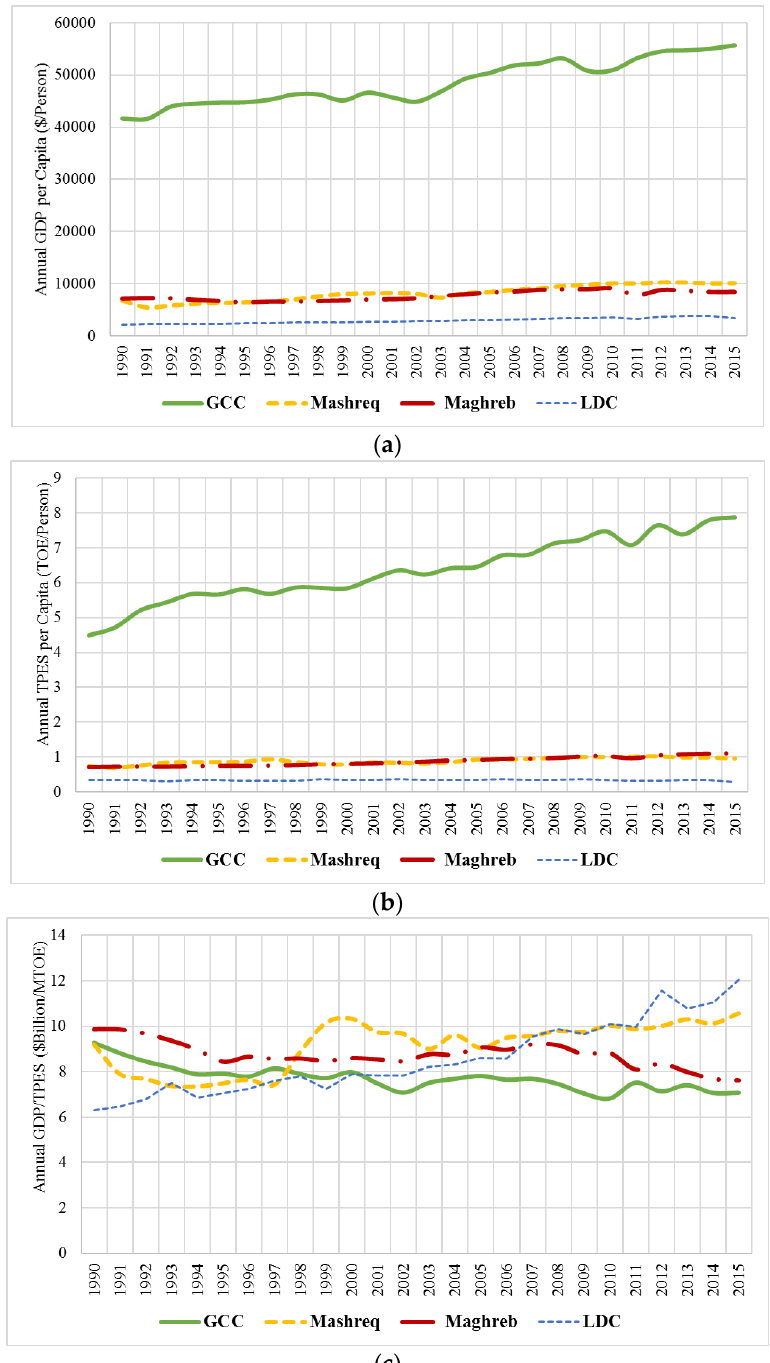
Figure 5. Annual variation of ( a ) per capita GDP, ( b ) per capita TPES, and ( c ) energy productivity for the Arab sub-regions.